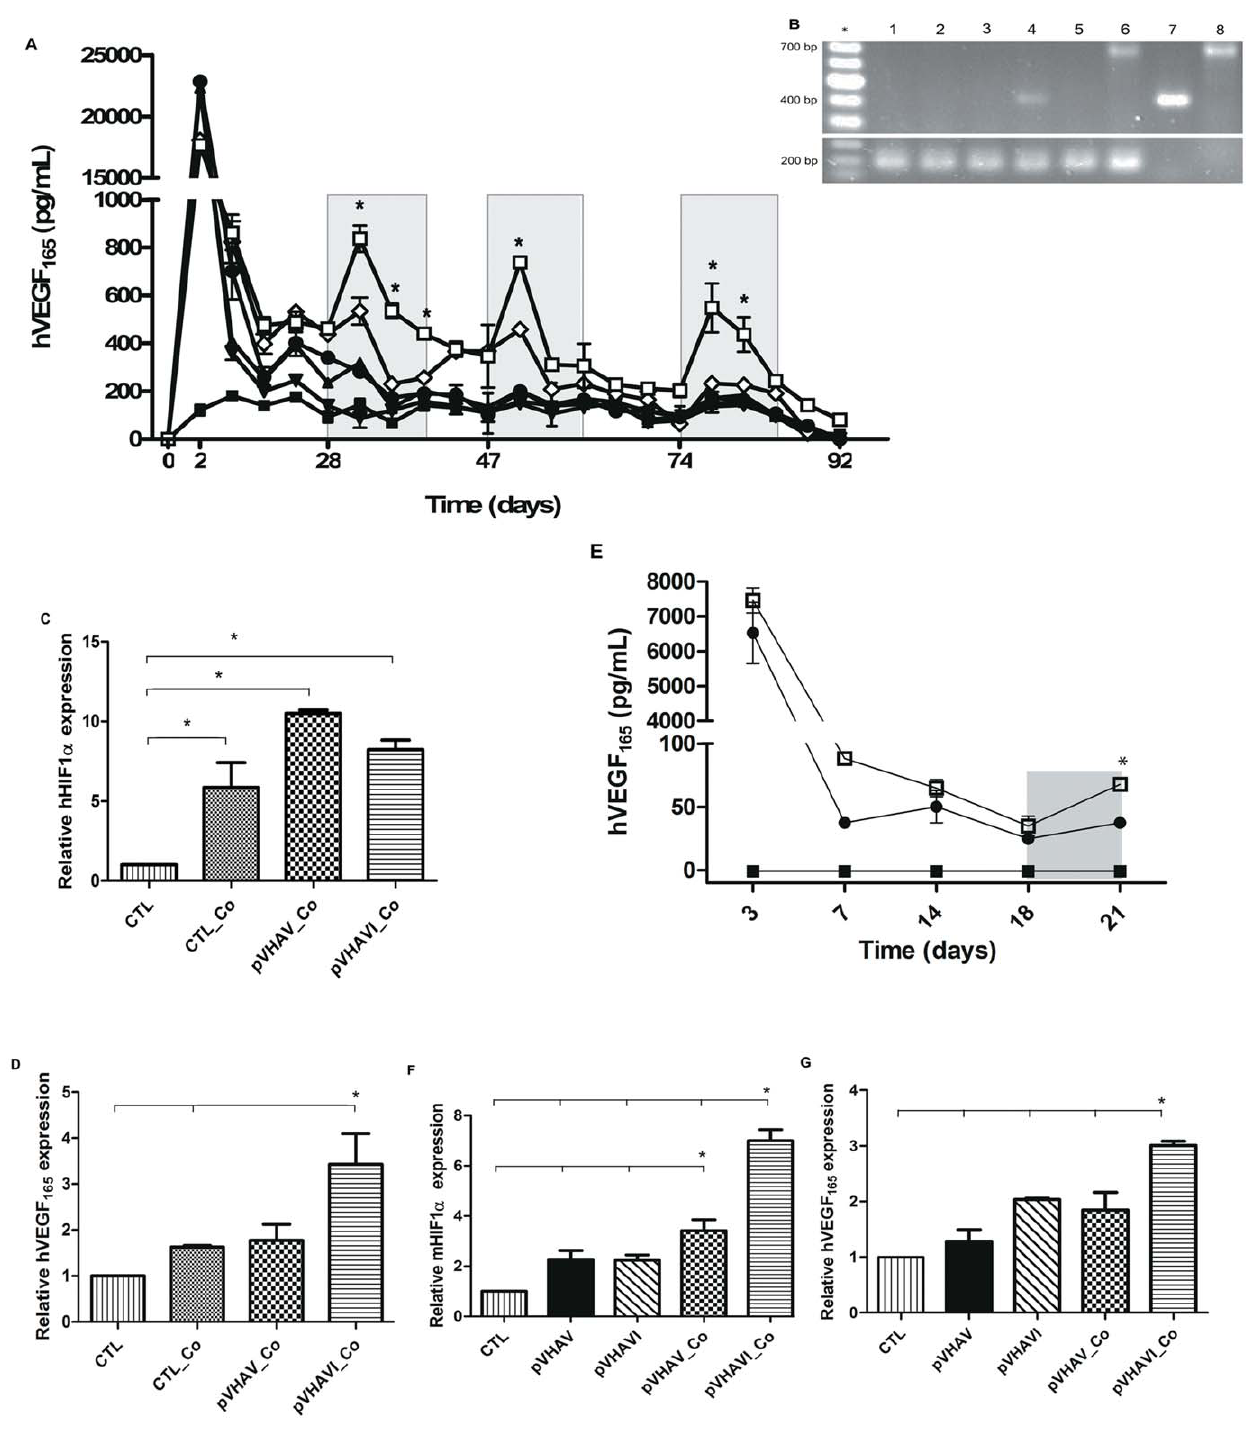
Figure 2. Assessment of VEGF expression vectors. (A) hVEGF 165 production under hypoxia and normoxia in HEK293 cells. On days 28, 47 and 74, N CoCl 2 was added to a final concentration of 100 m M, and the medium was replaced every 3 days with fresh medium containing CoCl 2 for 9 days (gray - pVHAV;- % - pVHAVI.* p , 0.001,pVHAVIincomparison to allgroups.(B)GenomicDNAPCR bars). - & - no transfection;- m - pVV; - . - pVAV;- e - pVAVI;- after 4 weeks of transfection. 1: no transfection; 2: pVV; 3: pVAV; 4: pVAVI; 5: pVHAV; 6: pVHAVI; 7: pVAX-attB-hVEGF 165 (432 bp); 8: pVAX-HRE-attB- hVEGF 165 (725 bp). The 200 bp band is from GAPDH. * 100 bp ladder. pVV: pVAX-hVEGF 165 + pVAX; pVAV: pVAX-attB-hVEGF 165 + p-INT; pVAVI: pVAX- attB-hVEGF 165 + uP-INT; pVHAV: pVAX-HRE-attB-hVEGF 165 + p-INT pVHAVI: pVAX-HRE-attB-hVEGF 165 + uP-INT (C) HIF1 a and (D) hVEGF 165 expression in HEK293 cells. On day 15 the HEK293 cells from the experiment (A) were collected for analysis by qRT-PCR. CTL: control; Co: CoCl 2 ; * p , 0.05. (E) hVEGF 165 N production under hypoxia and normoxia in C2C12 cells. On day 18 CoCl 2 was added to a final concentration of 100 m M and 3 days later the medium was - pVHAV; - % - pVHAVI. * p , 0.05. (F) HIF1 a and (G) hVEGF 165 expression in C2C12 cells. collected for VEGF quantification by ELISA. - & - no transfection; - On day 15 the C2C12 cells from the experiment (C) were collected for analysis by qRT-PCR. CTL: control; Co: CoCl 2 ; * p , 0.05 of pVHAVI_Co group versus all other groups. doi:10.1371/journal.pone.0033944.g002 PLoS ONE |